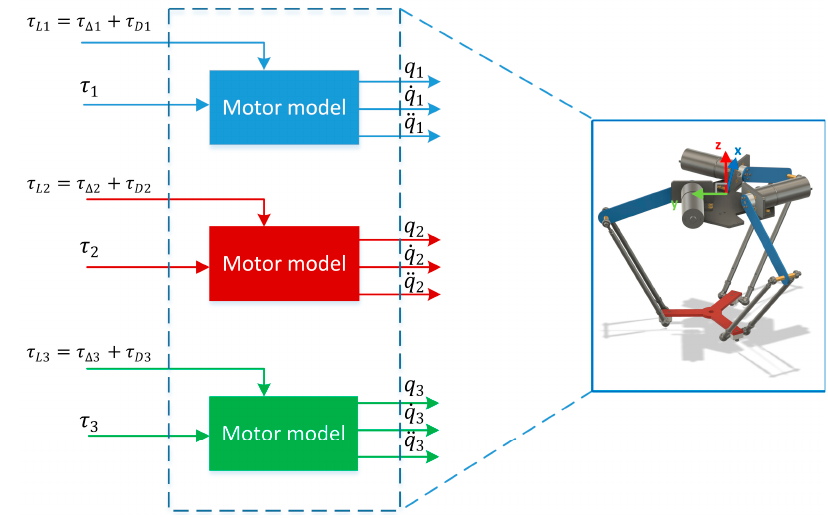
Figure 4. Parabolic characteristics: position transition in workspace ( a ), versus time ( b ); in joint space ( c ), angular velocities ( d ); angular accelerations ( e ); torques of delta manipulator ( f ).